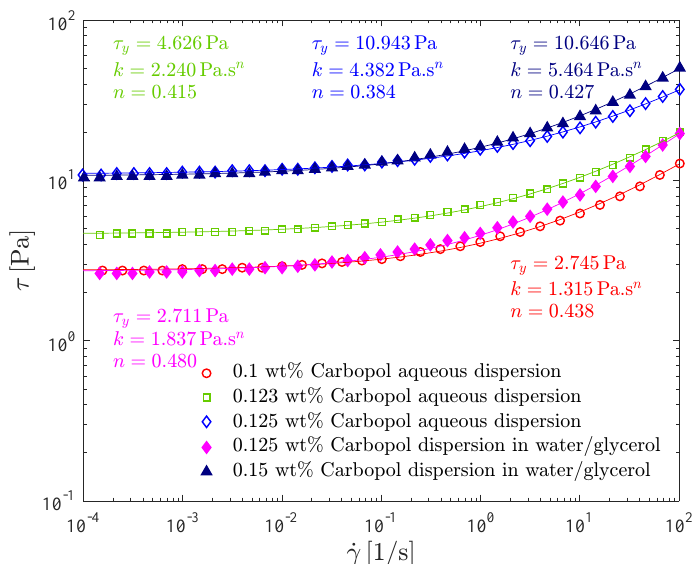
Figure 7. Solvent and polymer concentration influence on flow curve tests: shear stress as a function of shear